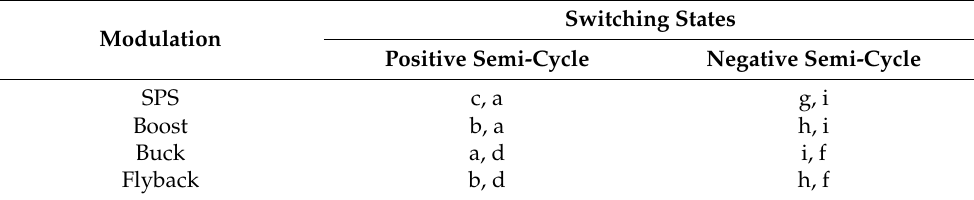
Table 2. Two-stage modulations possible states.